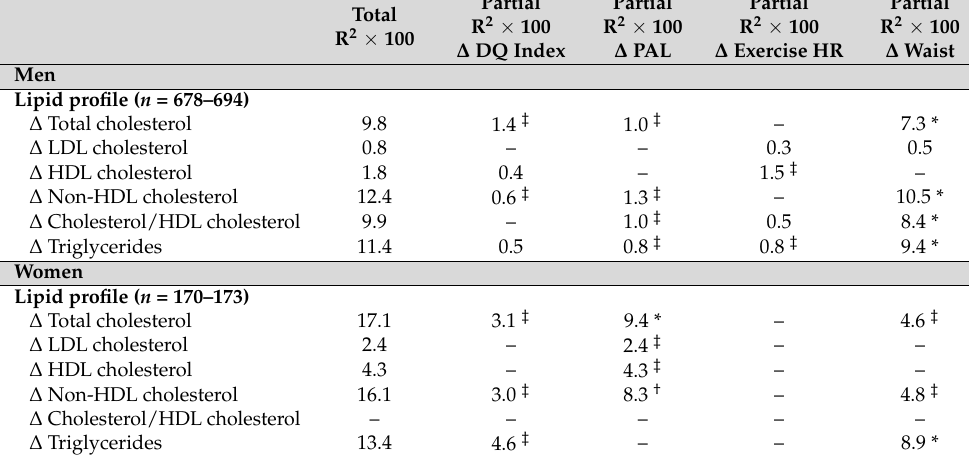
Table 5. Multiple linear regression models showing the independent associations of changes in diet quality index, physical activity level, exercise heart rate, and waist circumference on changes in lipid